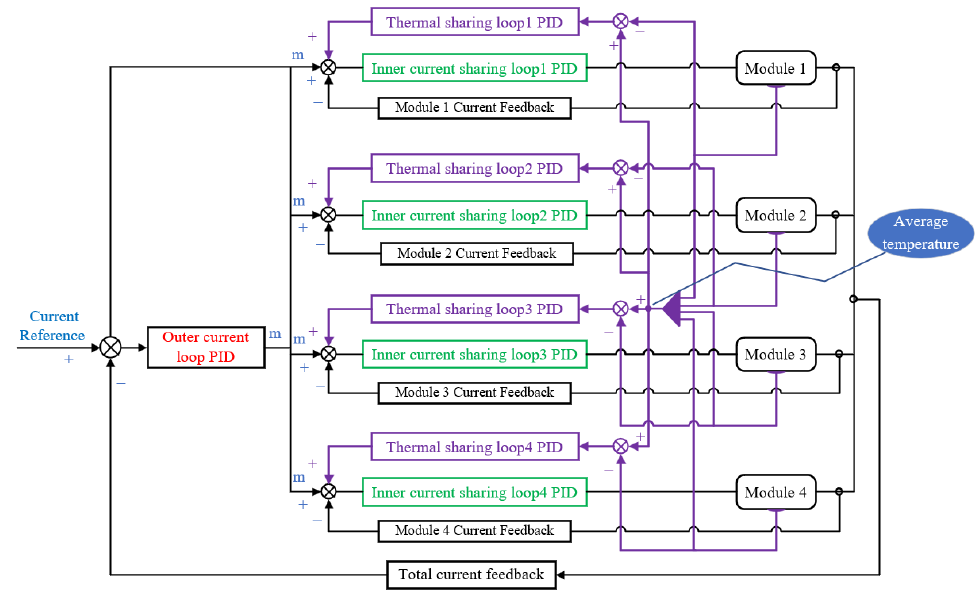
Figure 7. Block diagram of thermal